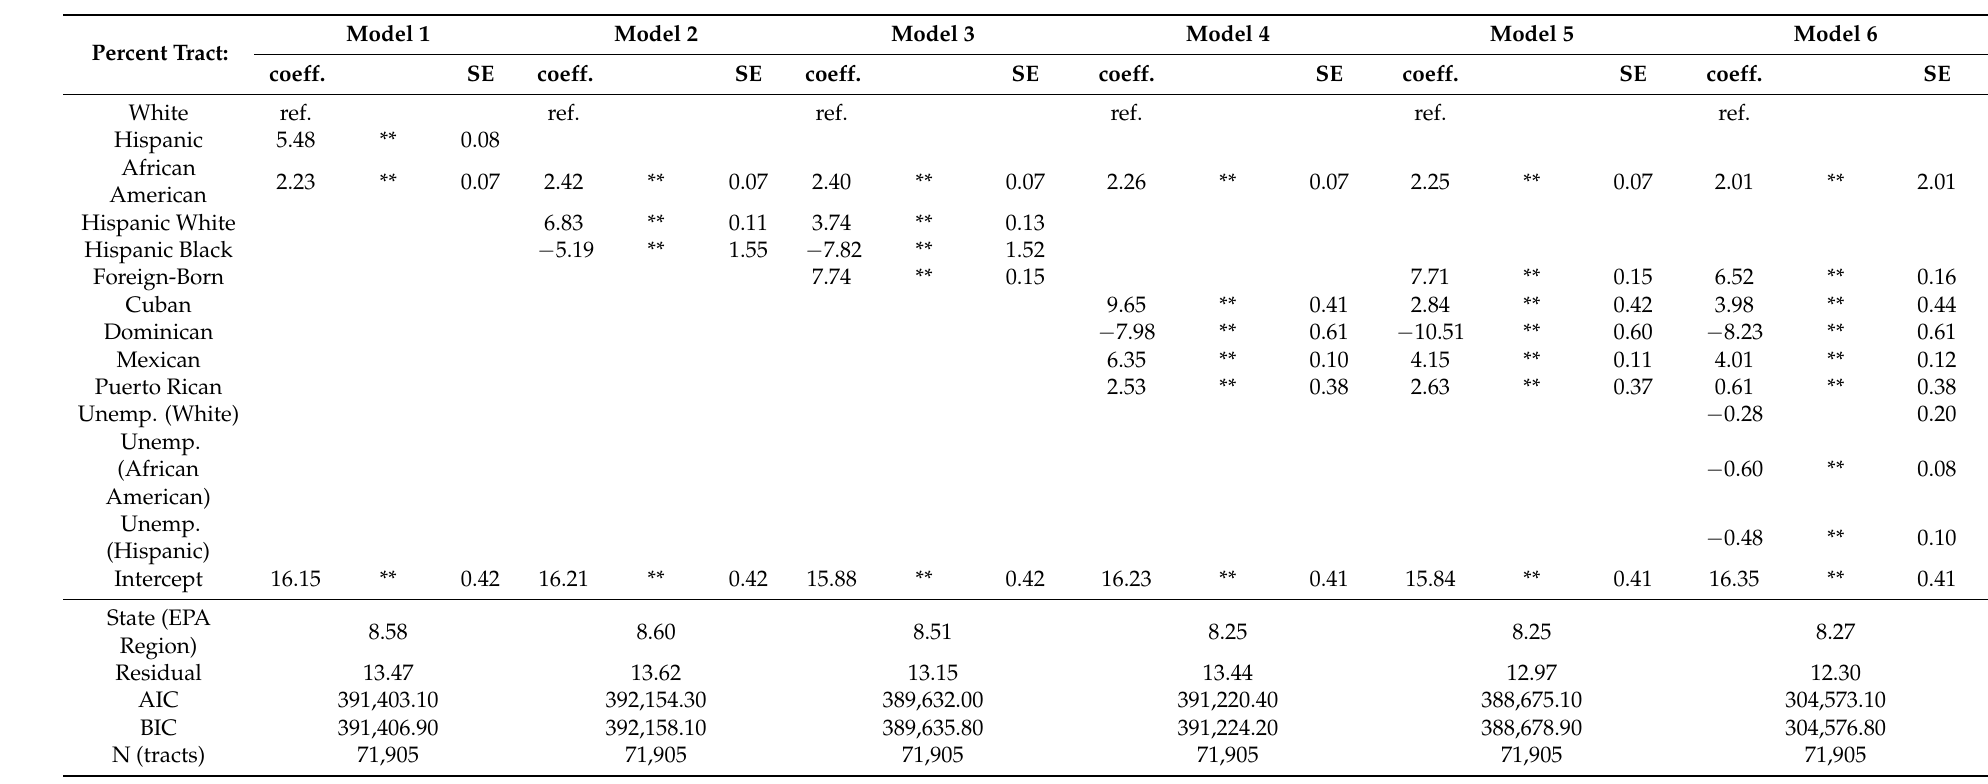
Table 4. Results from the linear mixed model predicting tract-level PM 10